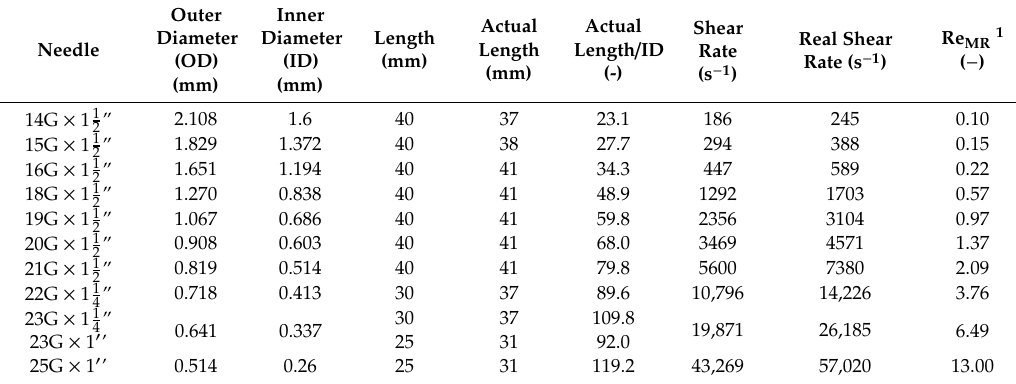
Table 1. Needles used in